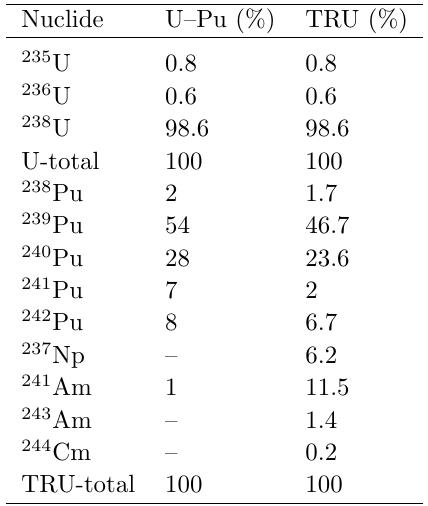
Table 2. Fuel composition of enhanced high burnup CFV